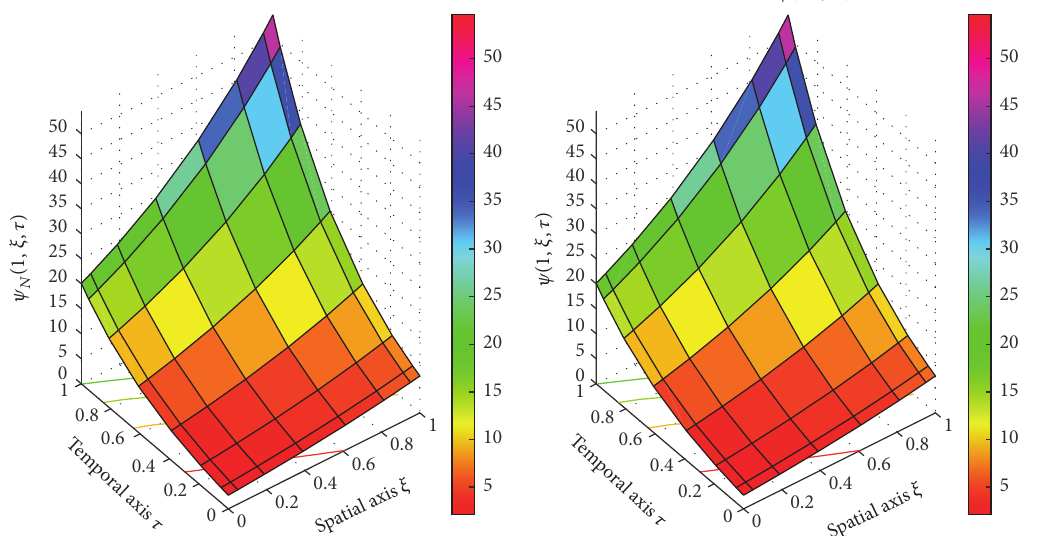
(1 , 𝜉,𝜏) obtained by BCM for N = 7 N